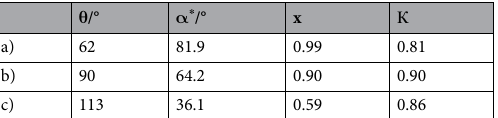
Table 1. Relaxation parameter determination on three different